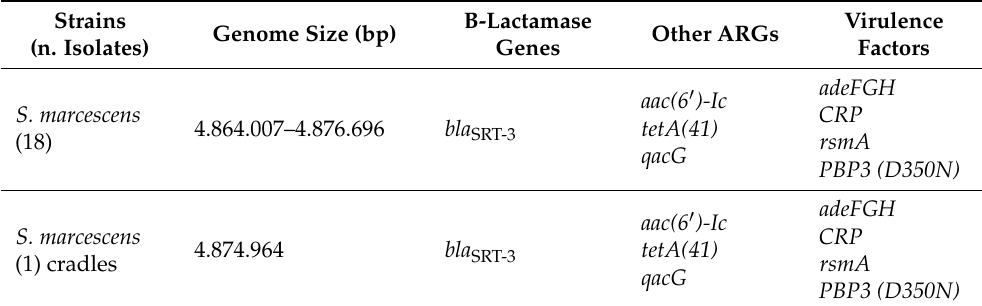
Table 2. Resistome and virulome analysis of clinical and environmental S. marcescens